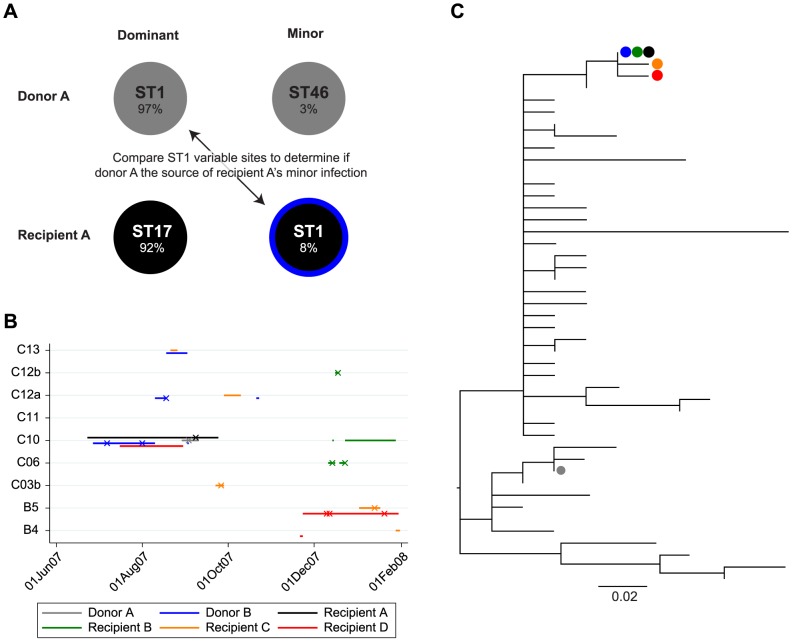
Phylogenetic and epidemiological relationships between cases related to a detected mixed infection.Panel A shows a depiction of the 2 mixed infections identified in donor A and recipient A. A transmission event from donor A to recipient A was predicted by a stochastic transmission model based on ward admission data. However donor A and recipient A had differing multilocus sequence types (STs) on initial testing of a single isolate from each case, suggesting a possible undetected mixed infection. Using the mixed infection estimator a minor ST infection in recipient A was found sharing the same ST, ST1 as donor A. However, applying the estimator to variable sites within ST1, the minor sequence in recipient A was most likely to have arisen from another case, donor B, shown in blue. Panel B shows the epidemiological relationships between donor A, recipient A, donor B and cases sharing similar sequences. Ward stays are shown as horizontal lines and positive tests as crosses. Panel C shows a phylogenetic tree of 45 distinct whole genome sequences from Oxfordshire patients with ST1 Clostridium difficile infection. Maximum likelihood tree based on 79 variable sites identified drawn using PhyML [36]. The donor proposed by the transmission model is shown in grey (donor A). The minor sequence in recipient A is shown in black, matching the sequence found in donor B, in blue. Recipient B shared an identical sequence to recipient A. Recipients C and D are two cases phylogenetically descended from the donor B, recipient A, recipient B sequences. Note only donor A and recipient A were analysed for the presence of mixed infection.